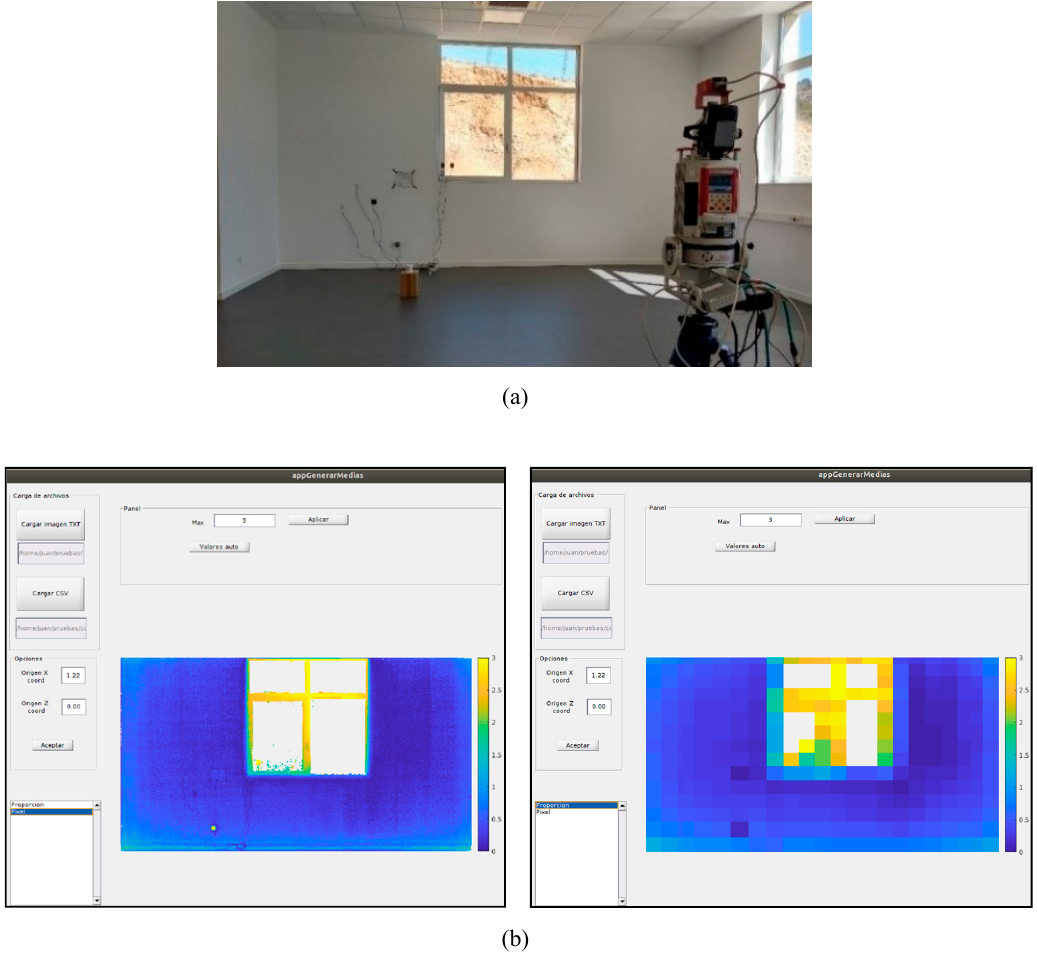
Figure 16. 3D-TTA Module 3_1: ( a ) Wall used to illustrate the results of Module 3.1. ( b ) User interface showing the difference thermal-images with different resolutions: original resolution of the thermal orthoimage (left) and resolution of DesignBuilder (right).